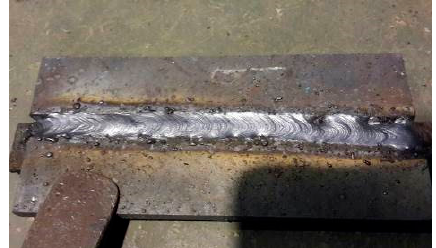
Figure 12. VR Welding Simulation Screen. Electronics 2020 , 9 , x FOR PEER REVIEW